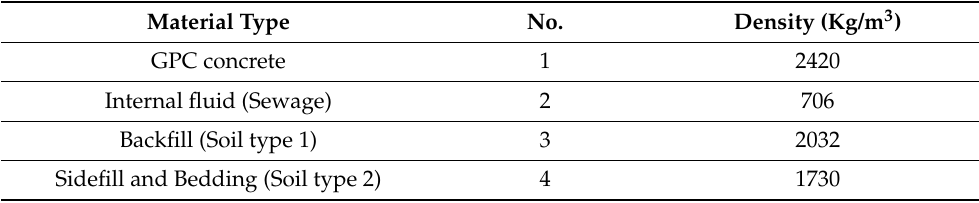
Table 10. Material number defined for meshing in